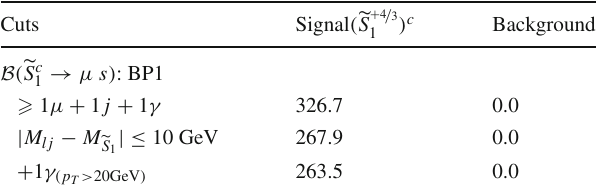
Table7 Numberofeventsafterthecumulativecutsforthescalarsinglet leptoquark (cid:8) S c and SM background at 1 100 fb − 1 at HERA